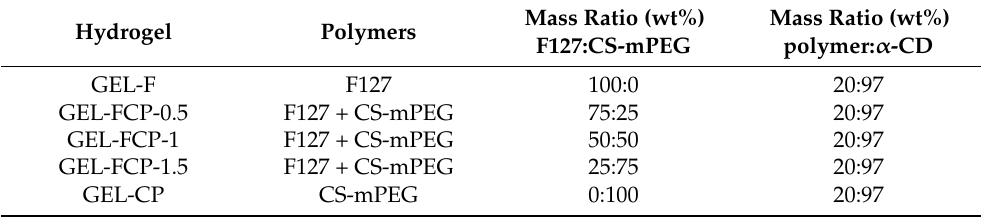
Table 1. Formulation of